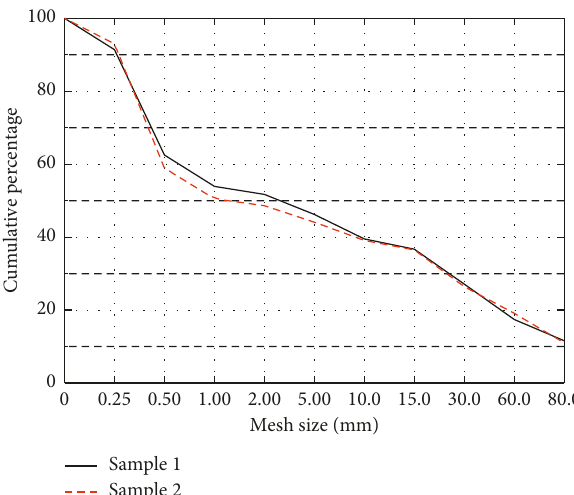
Figure 4: Grain size distribution of the soil